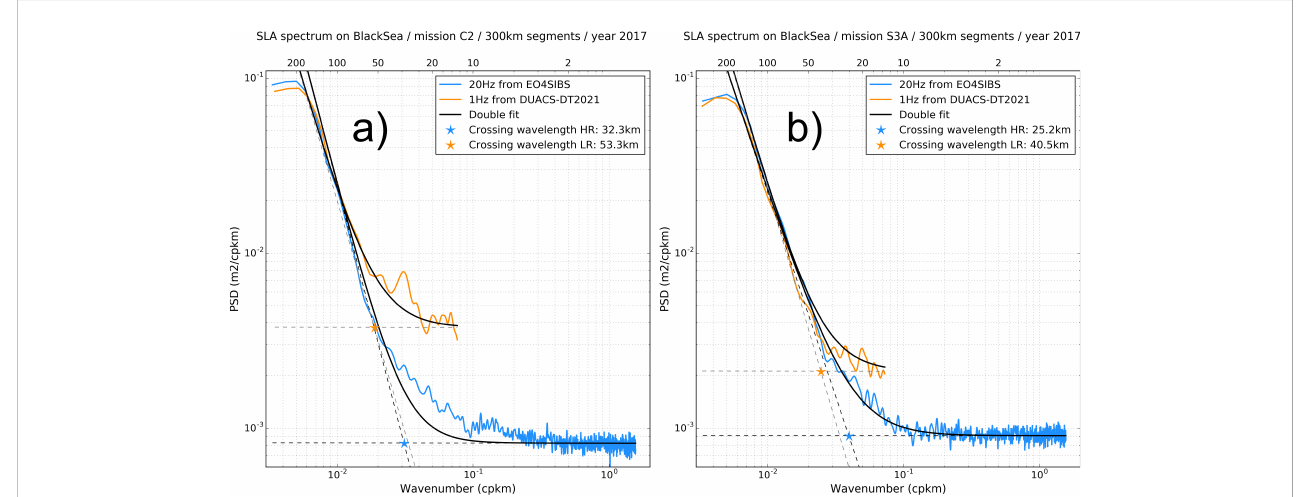
FIGURE 6 Mean SLA PSD over the Black Sea region, deduced from Cryosat-2 (A) and Sentinel-3A (B) measurements. The PSD obtained from 20Hz (resp. 1Hz) measurements is presented in blue (resp. orange). The spectral slope and noise level deduced from the PSD analysis are presented in dotted black lines, while theoretical spectrum, de fi ned as the sum of the spectral slope and noise, are presented in thick black lines. The intersection between the spectral slope and noise level is symbolized by a blue (yellow) star for 20Hz (1Hz) measurements. It is representative of the SNR equal